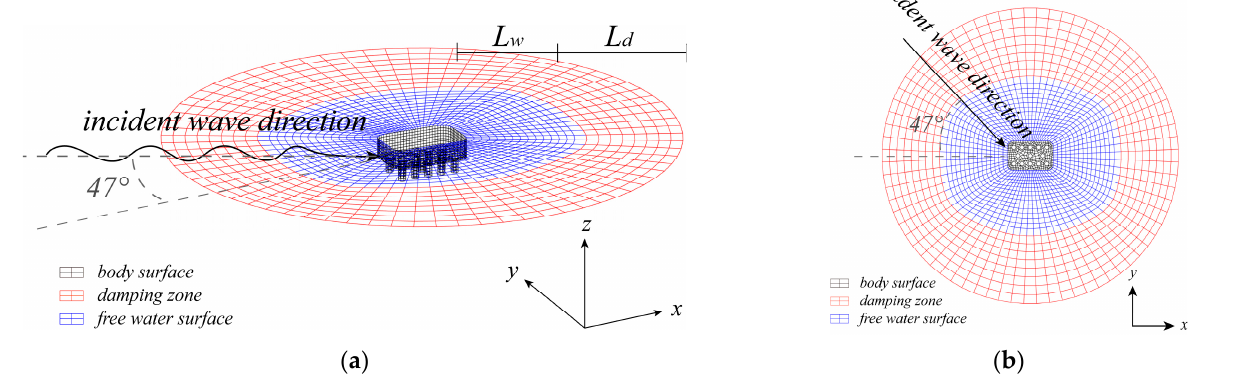
Figure 6. Mesh of the cofferdam. ( a ) Stereoscopic view; ( b ) Vertical